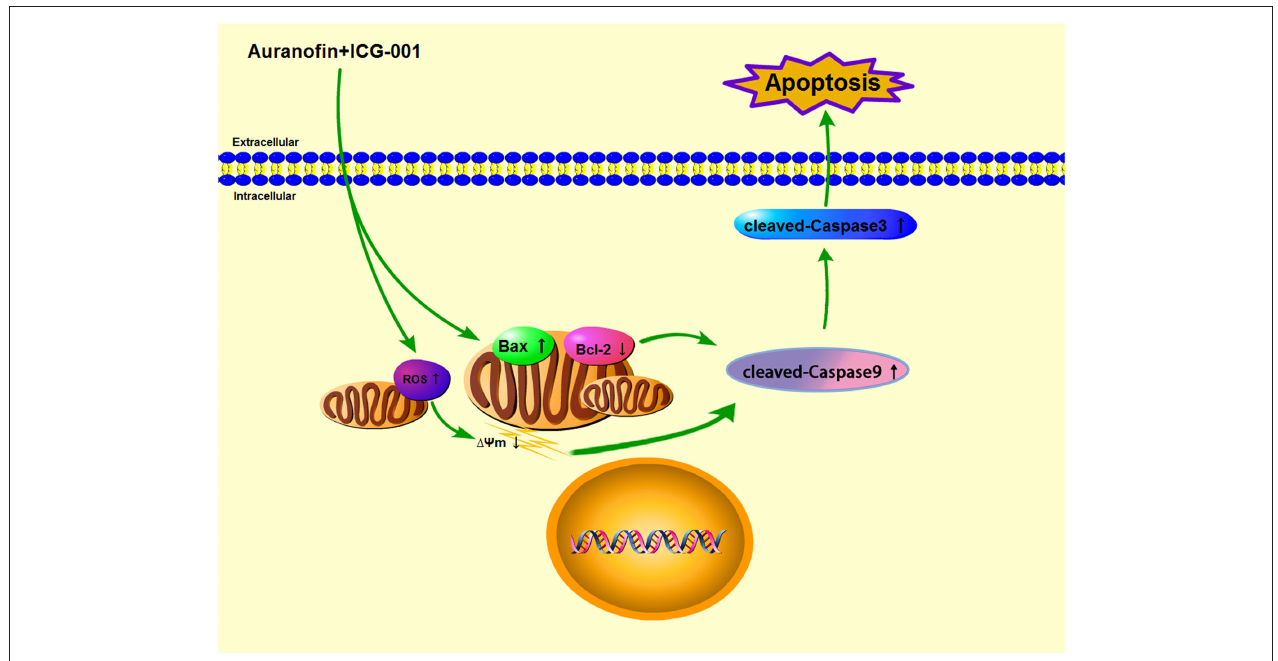
FIGURE 8 | The underlying mechanism of combination of AF and